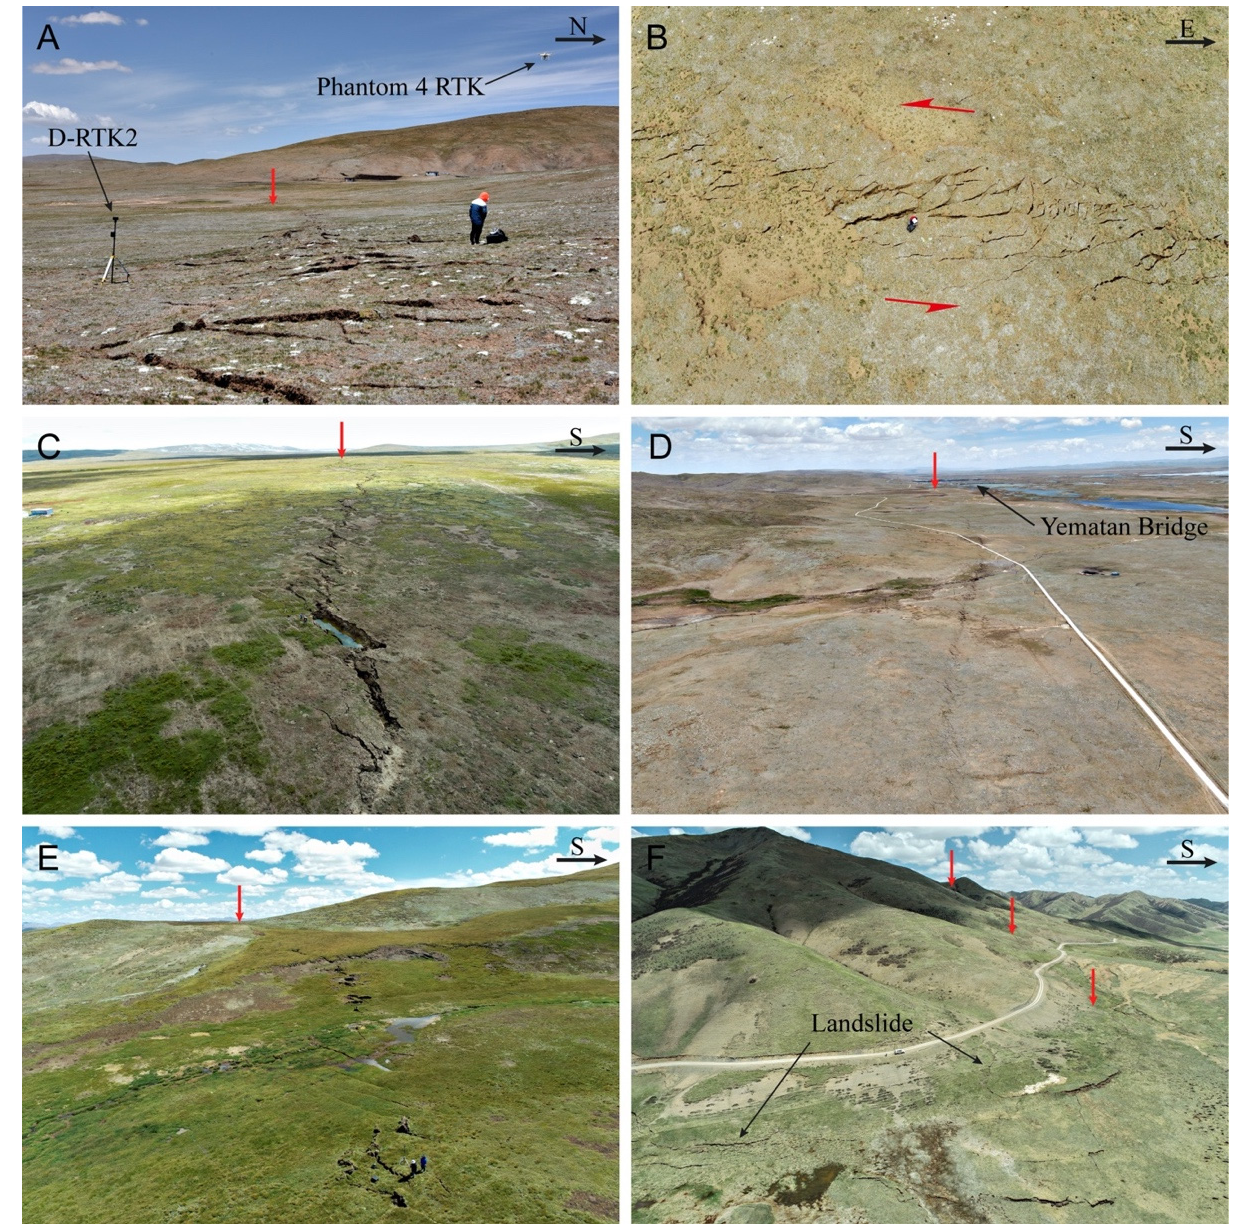
Figure 3. ( A ) Field operation of drone. ( B – F ) Coseismic surface rupture observed from the air. The red arrows point to the extension direction of the rupture. In ( D ), the collapsed Yematan Bridge is visible in the distance. In ( F ), landslides were caused on the slopes where the fault passed.